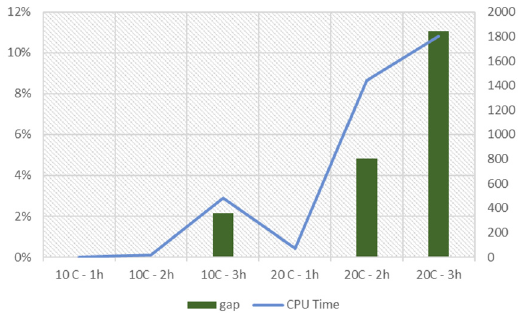
Figure 6. Impact of time window durations on optimality gap (%) and computational time (secs).